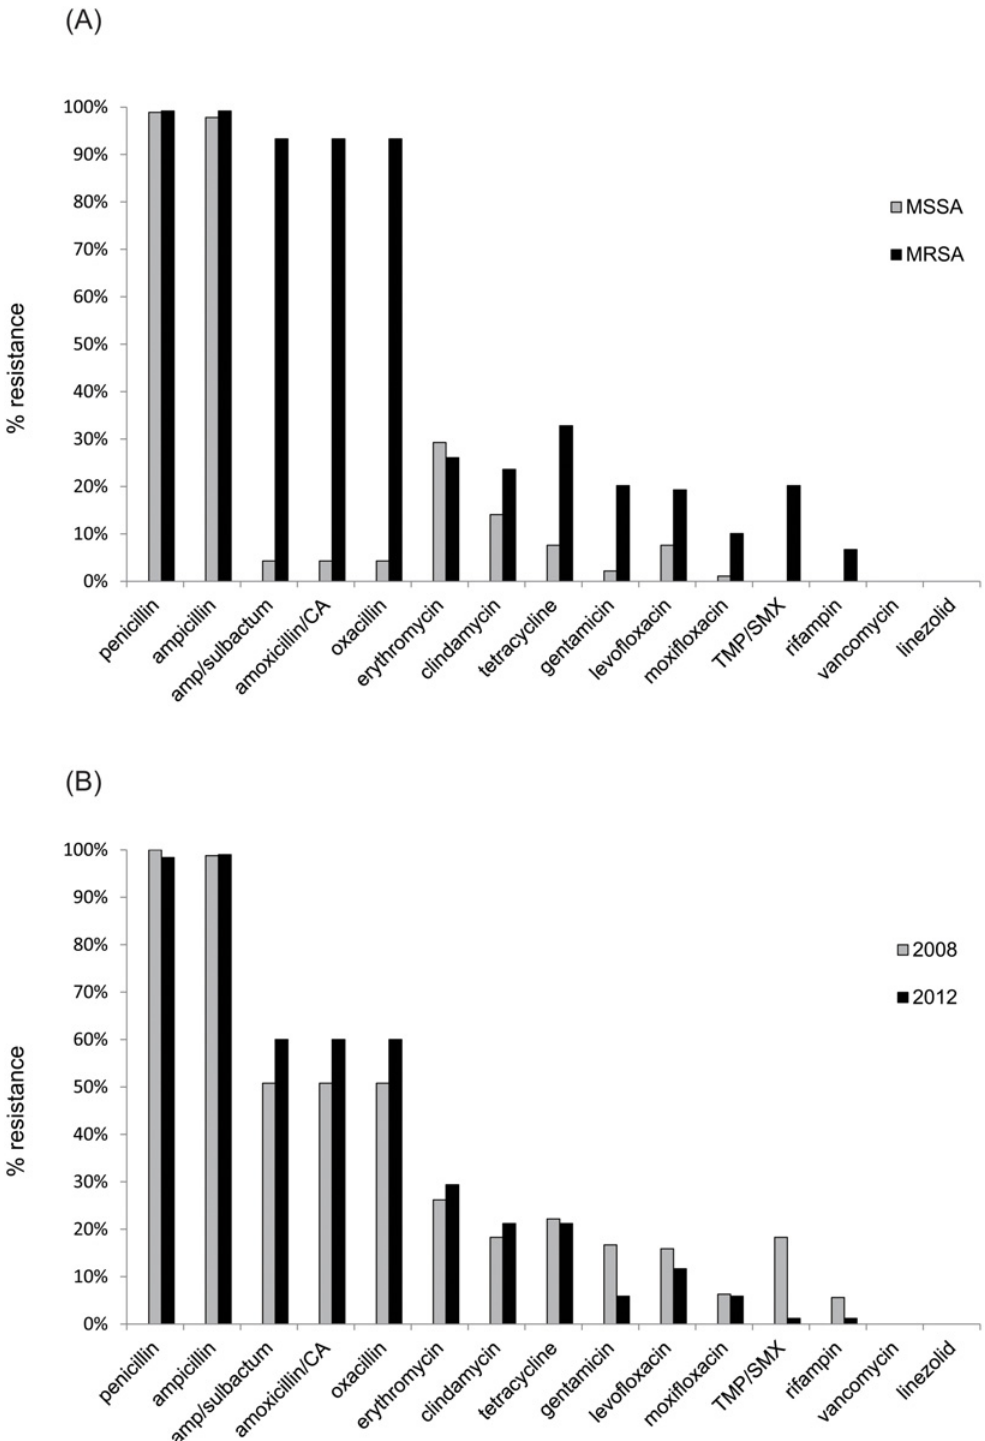
Fig 1. Antimicrobial resistance frequencies among S . aureus isolates in this study. Vertical bars denote relative resistance to selected antimicrobials described in the text. a. Black bars denote percent resistance among MRSA isolates; gray bars denote resistance among MSSA isolates. b. Gray bars denote percent resistance among S . aureus isolates from 2008; black bars denote resistance among S . aureus isolates from 2012. Only antimicrobials tested in both 2008 (VITEK 2) and 2012 (MicroScan) are depicted. Amp, ampicillin; CA, clavulanic acid; MRSA, methicillin-resistant Staphylococcus aureus ; MSSA, methicillin-susceptible Staphylococcus aureus ; TMP-SMX, trimethoprim-sulfamethoxazole.